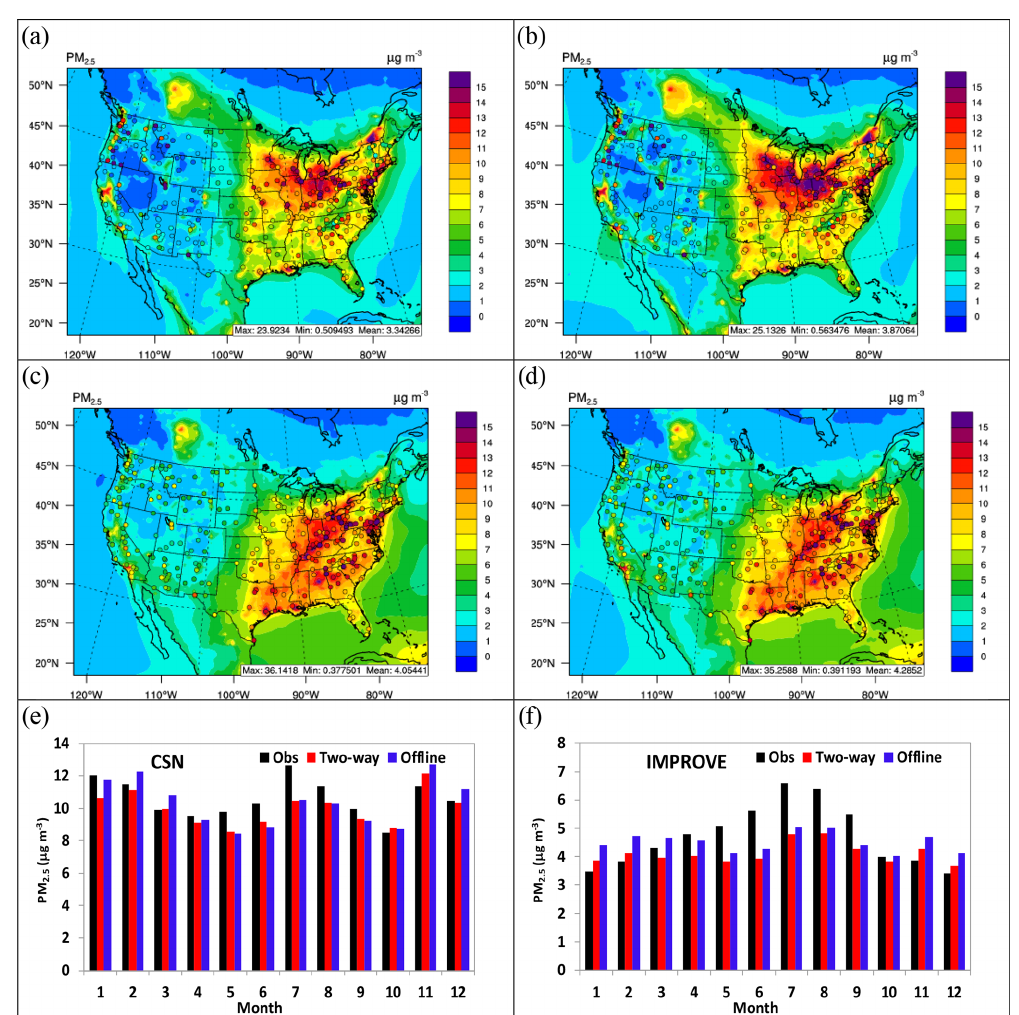
Figure 10. Spatial distributions of 5-year averaged daily PM 2 . 5 overlaid with observations from CSN and IMPROVE for two-way WRF- CMAQ in (a) winter and (c) summer and offline CMAQ in (b) winter and (d) summer. Bar charts for 5-year average monthly PM 2 . 5 between observations (black bar), two-way WRF-CMAQ (red bar), and offline CMAQ (blue bar) over (e) CSN and (f) IMPROVE in